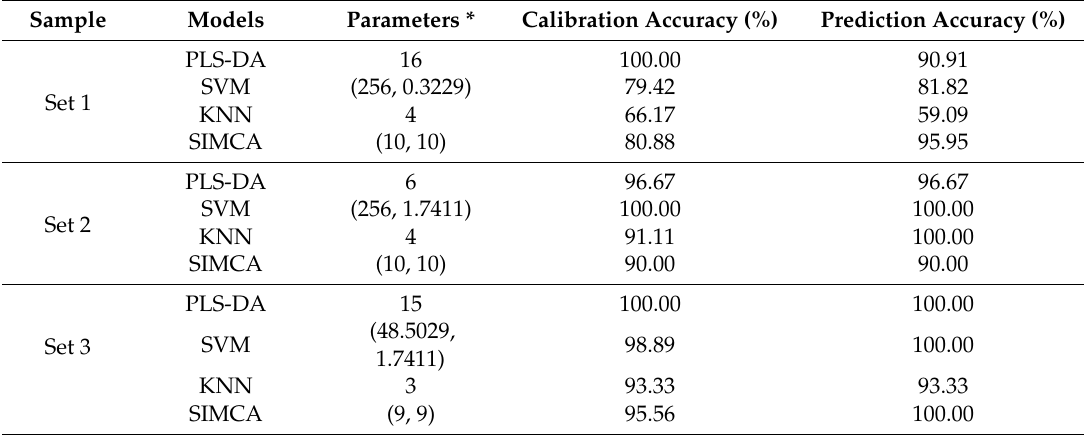
Table 1. The results of discriminant models using full spectra of three different sample